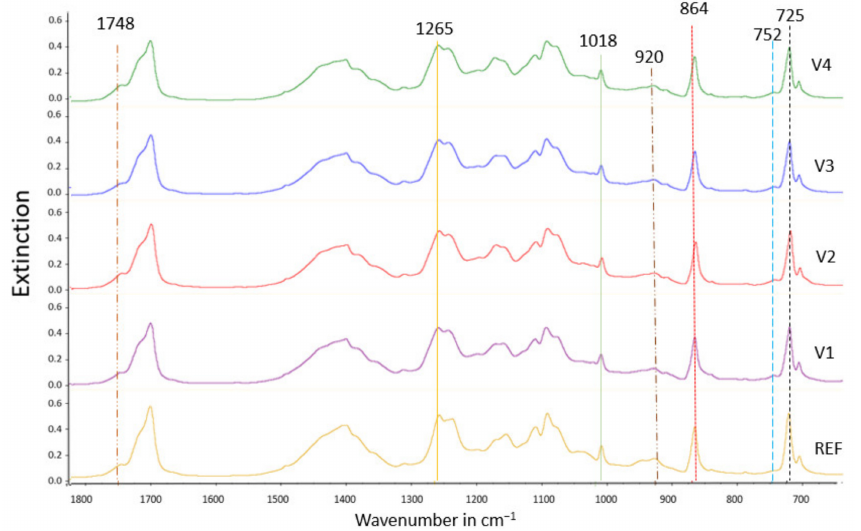
Figure 2. FTIR spectra of the blown films of unmodified PBAT/PLA (REF) and the CECL-modified samples (V1 to